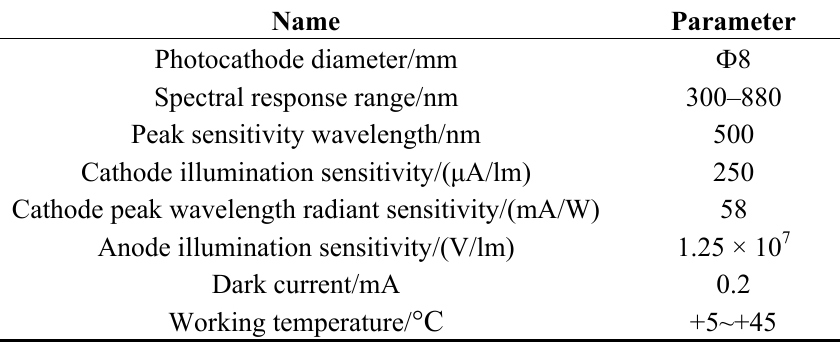
Table 2. Performance parameters of the H9656-02 PMT.